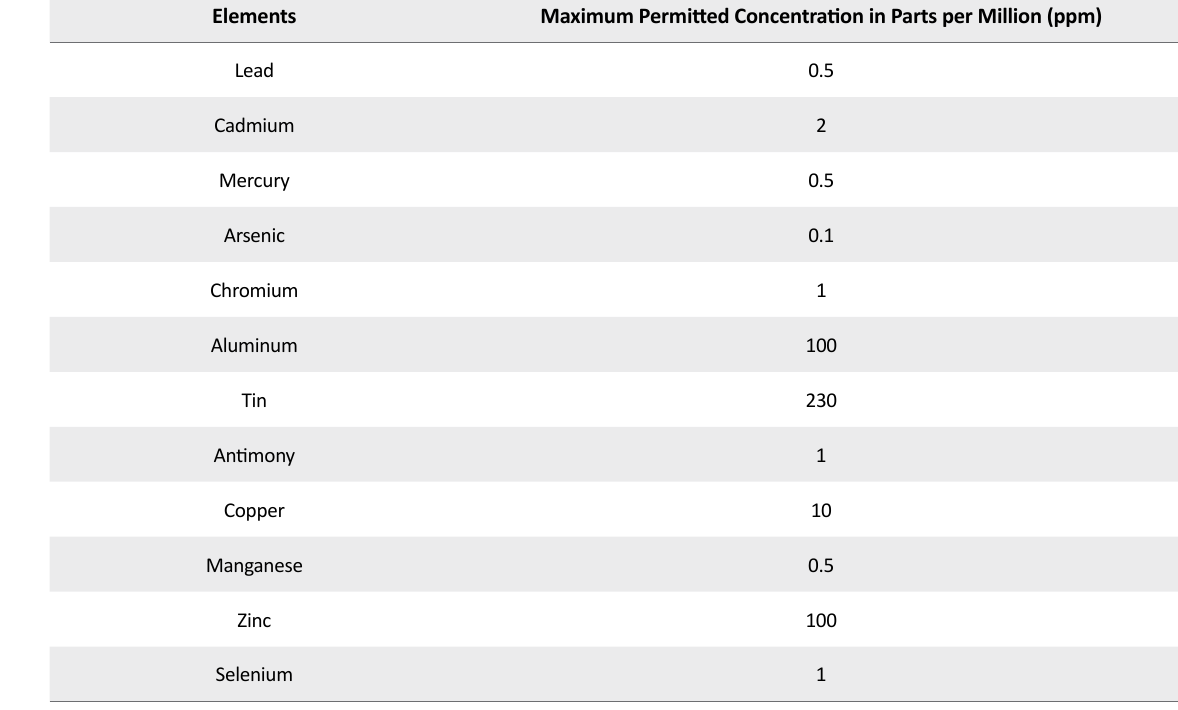
Table 2. Maximum allowed concentration as ppm (parts per million)